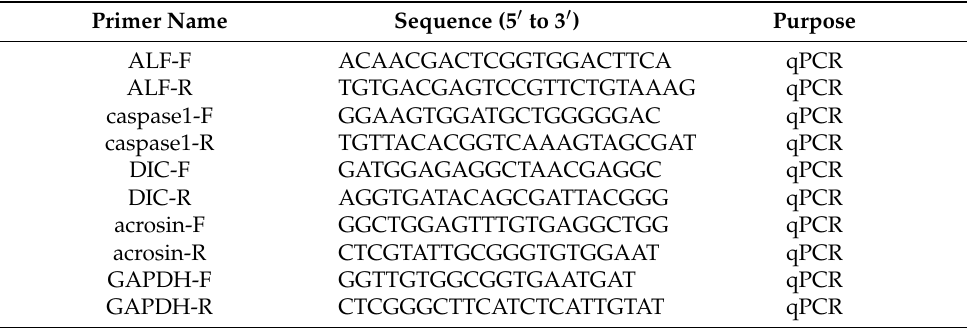
Table 2. The primer sequences used in this